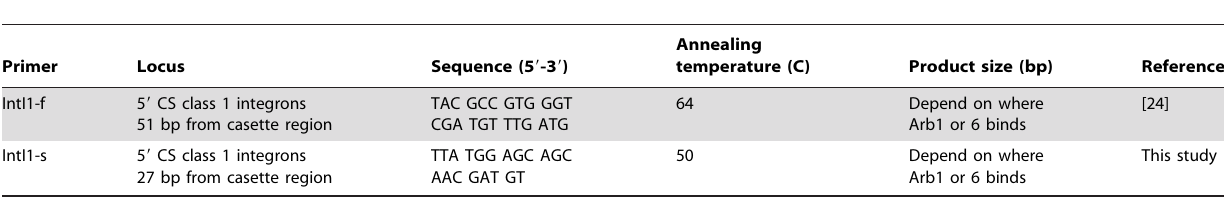
Table 2. Primers not previously published used in the semi random PCR and sequence analysis.